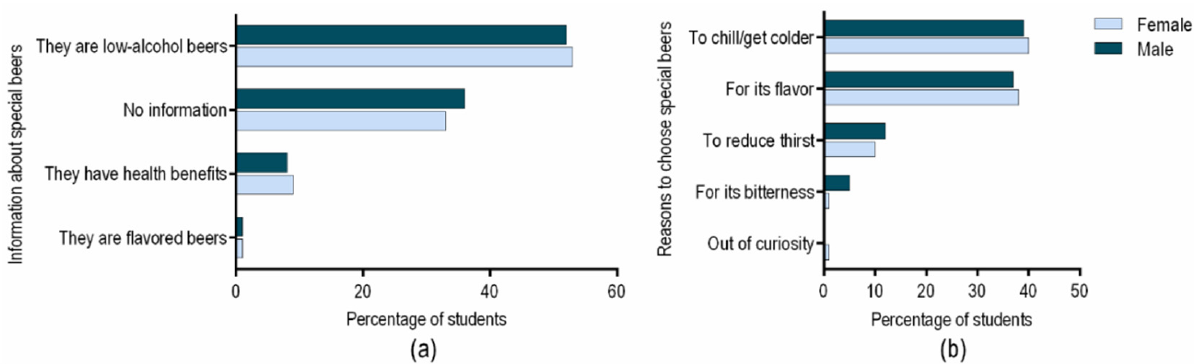
Figure 4. Information about the special beers already knew by students at the time of questionnaire ( a ). The main reasons why male and female students are choosing to drink special beers ( b ).